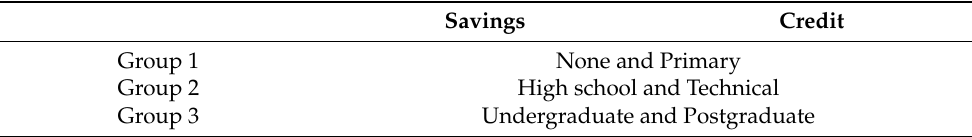
Table 3. Education level groups.